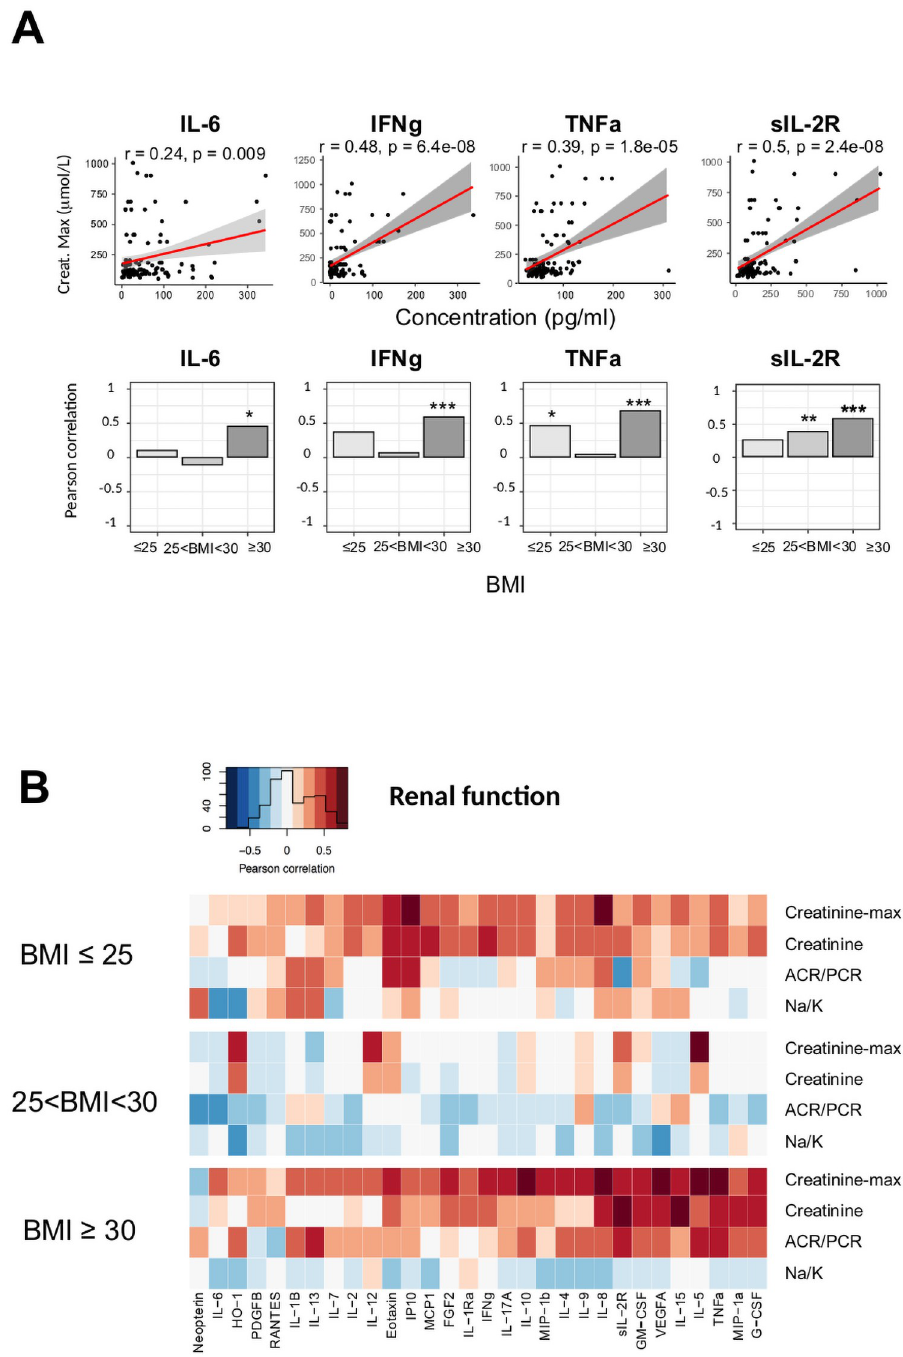
Fig 4. (A) Top panel: Linear regression curves between plasma concentration of IL-6, IFN γ , TNF α , GM-CSF, and the maximum level of creatinine. Bottom panel: bar plots showing the coefficient of the Spearman correlation of IL-6, IFN γ , TNF α , and GM-CSF with the maximum level of creatinine according to BMI (BMI � 25, 25 < BMI < 30, BMI � 30; � p < 0.05; �� p < 0.01, ��� p < 0.001). (B) The Spearman correlation heatmap depicts the negative (blue), positive (red), and no (white) correlation between markers of kidney dysfunction (i.e. maximum creatinine, creatinine, the albumin/creatinine ratio with protein/creatinine, the Na/K ratio, and the blood cytokines levels according to BMI (BMI � 25, 25 < BMI < 30, BMI �